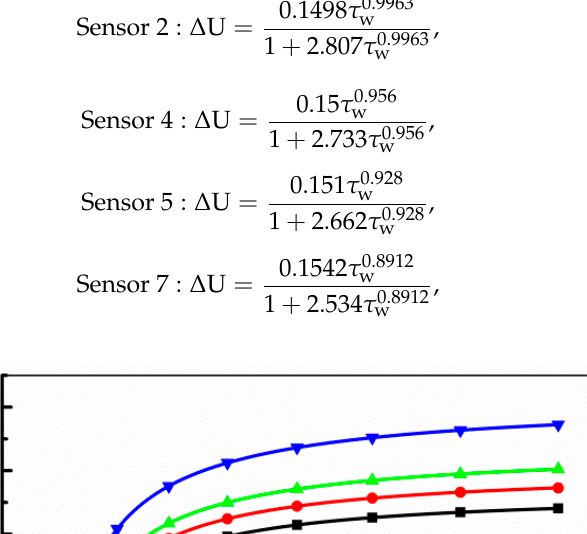
Figure 7. Calibration curves of four sensors.